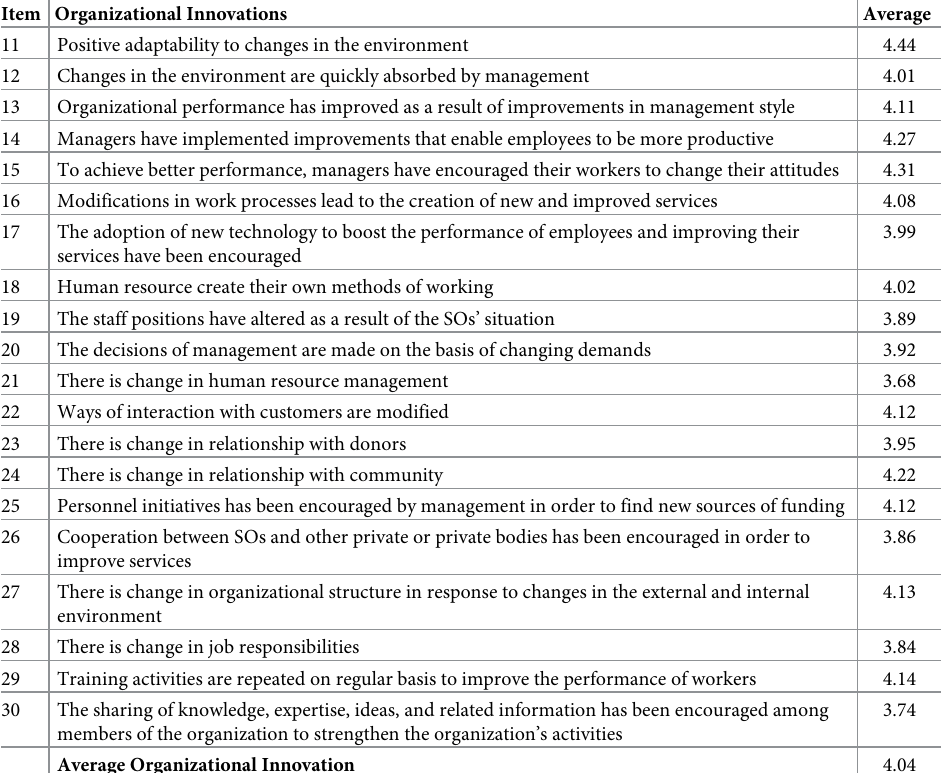
Table 2. Average percentage in the items of organizational innovations.